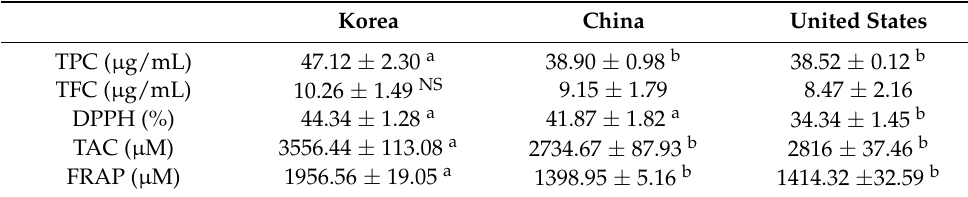
Table 7. Antioxidant activities of commercial kimchi manufactured in Korea, China, and the United